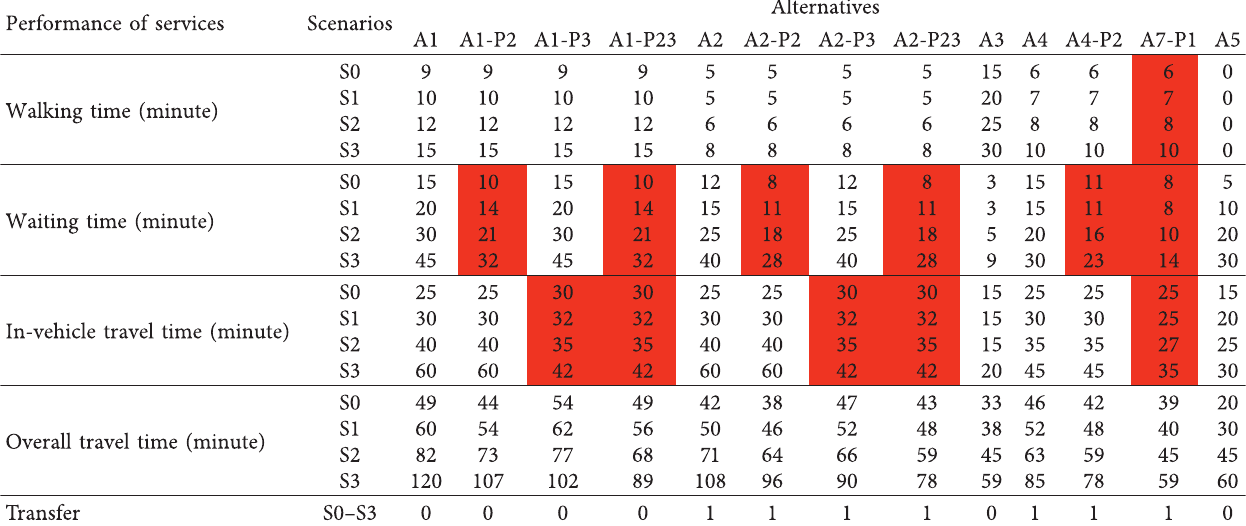
Table 6: Parameters of emergence plans.